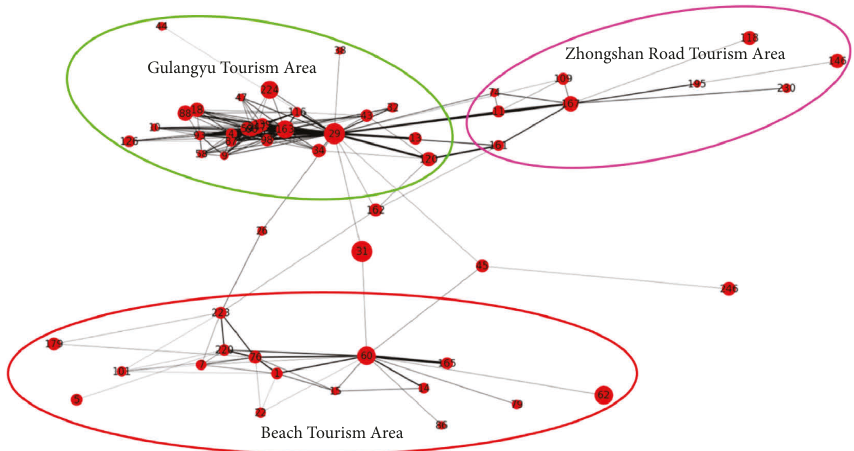
Figure 5: Tourism areas identified from the travel network ( θ